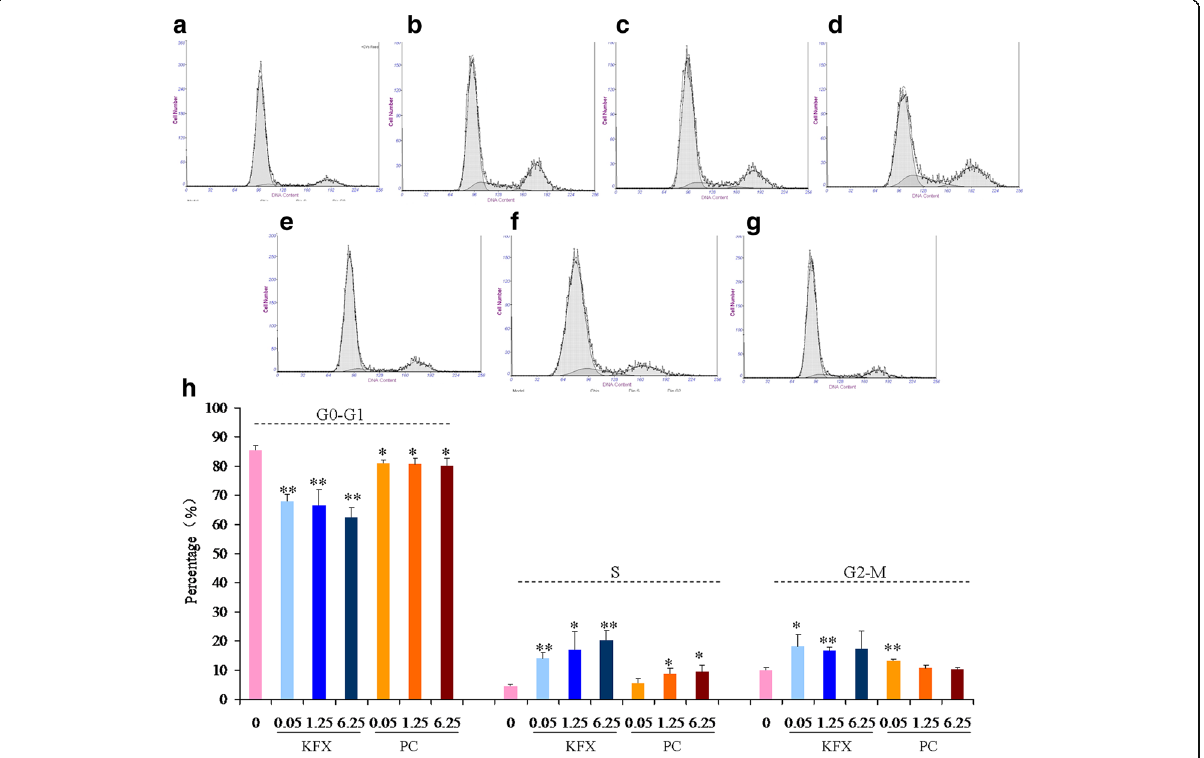
Fig. 8 FACS or cell cycle analysis of BMSCs. a Blank control (untreated), b KFX (0.05 mg/mL), c KFX (1.25 mg/mL), d KFX (6.25 mg/mL), e PC substance (0.05 mg/mL), f PC substance (1.25 mg/mL), g PC substance (6.25 mg/mL), h Extent of propidium iodide staining of the gated population was displayed in a histogram and the regions are defined as: G0/G1, S, and G2/M. Result shows the effect of KFX and PC substance in BMSCs population of G0-G1, S and G2-M cell cycle phase, compared with that of blank control group. Data are means ± SD of three independent